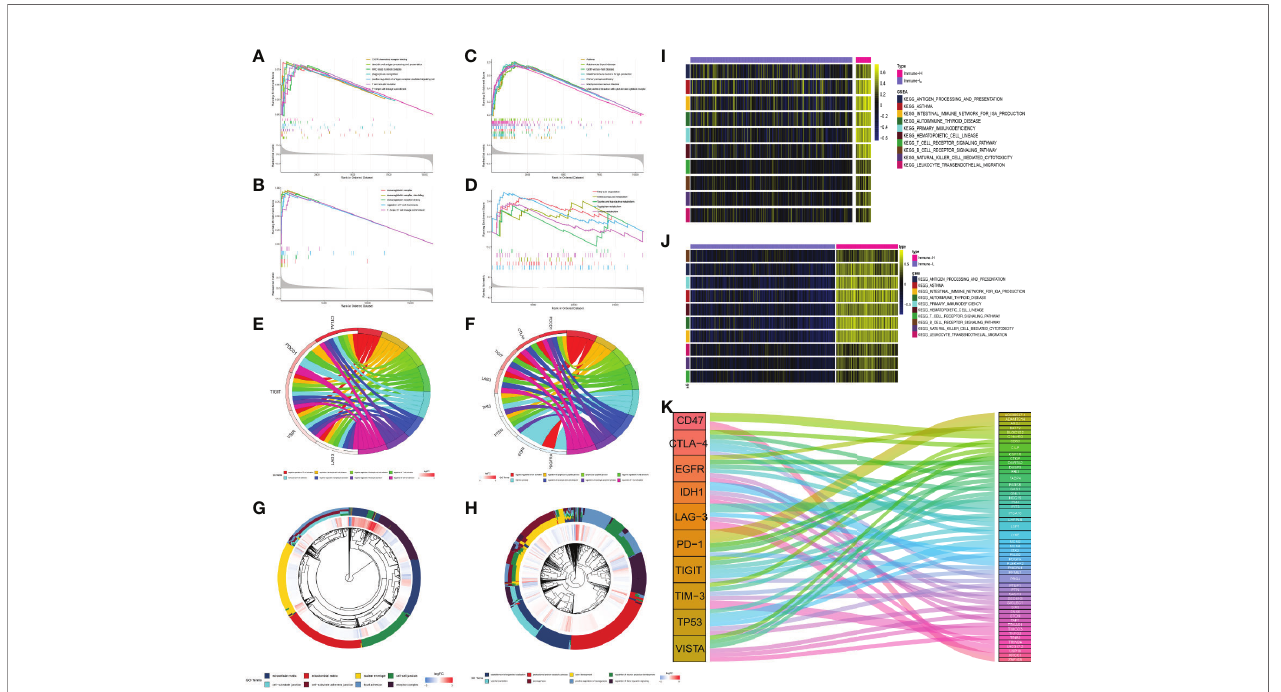
FIGURE 7 | Comprehensive functional analysis relating to the immune phenotypes. (A, B) GSEA of GO terms of metagenes co-expressed in the immune-H and immune-L phenotypes in the TCGA microarray and CGGA RNA-seq cohorts. (C, D) GSEA of pathways of metagenes co-expressed in the immune-H and immune-L phenotypes in the TCGA microarray and CGGA RNA-seq cohorts. (E – H) GO chord plots showing correlation and clusters of PDCD1, CTLA-4, TIGIT, LAG3, TP53, VSIR, PTEN, EGFR, PDGFRA checkpoints. (I, J) Variants in pathway categories demonstrated by GSVA relating to immune-H and immune-L phenotypes in TCGA microarray and CGGA RNA-seq cohorts. (K) The Sankey diagram showed multiple correlations between CD47, CTLA-4, EGFR, IDH1, LAG-3, PD-1, TIGIT, TIM-3, TP53, VISTA and their top-ranked correlated genes in glioma.